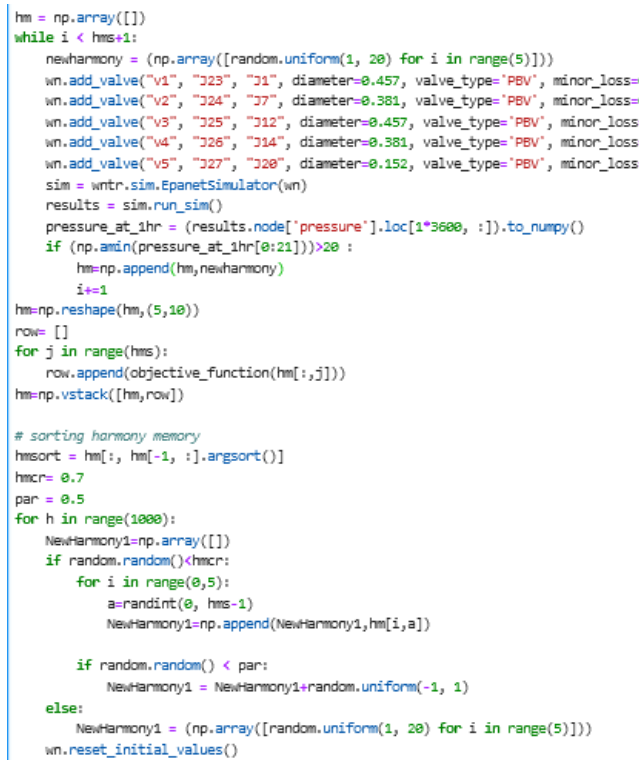
Figure 12. Source Code of Python Script.